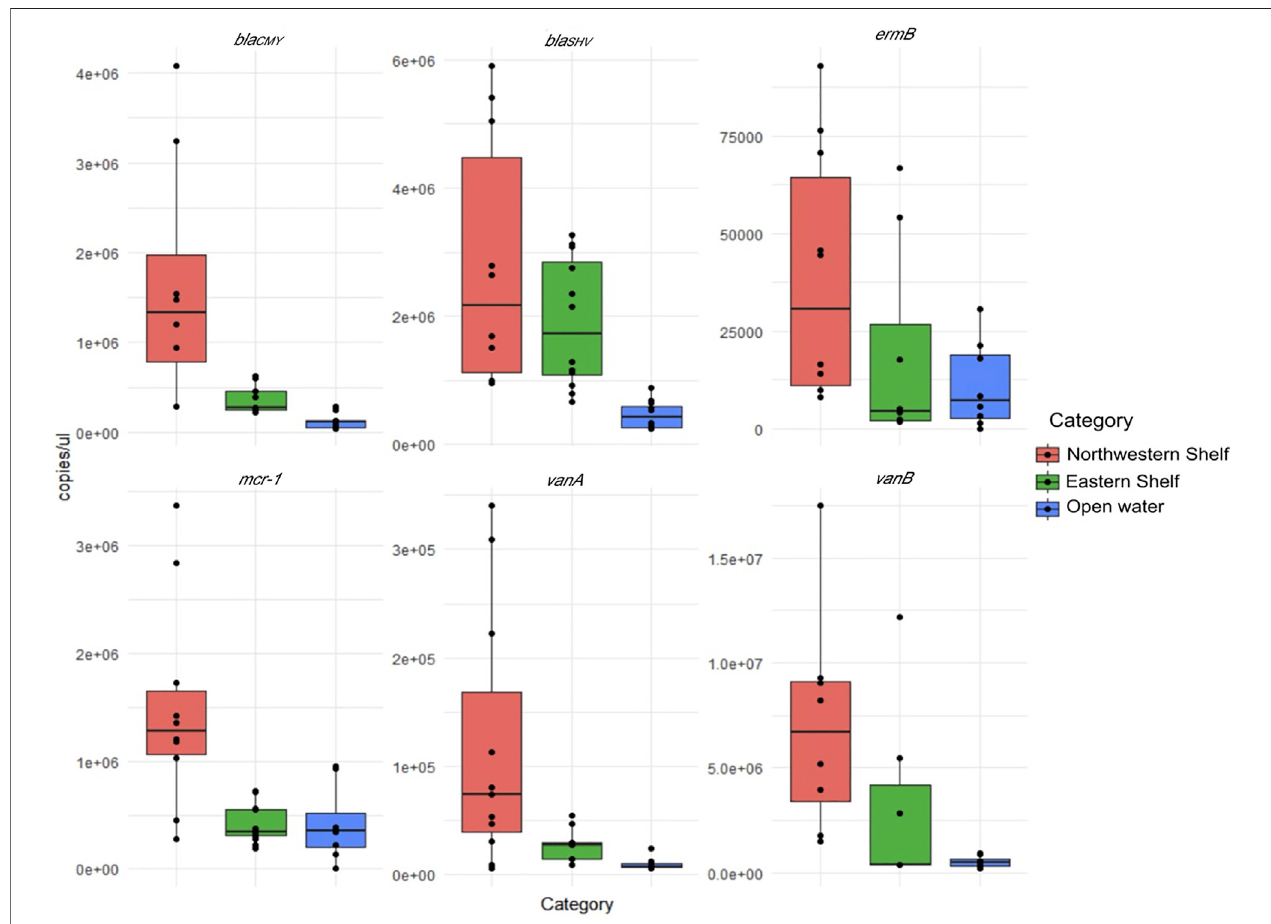
FIGURE 2 | Absolute number of ARGs in northwest shelf (stations 1A, 2A, 2, and 3), eastern shelf (stations 9, 10, 11, 12) and open waters (stations 4, 5, 7 and 8).